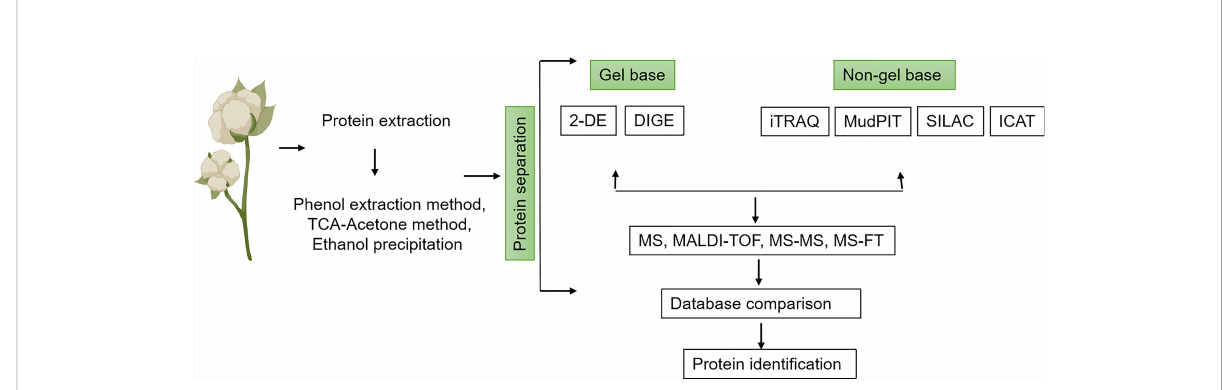
FIGURE 2 Schematic work fl ow of the different methods used in cotton proteomics analysis. Proteins are extracted from tissues of interest using any of the following methods: phenol extraction, TCA-Acetone, or ethanol precipitation. This is followed by protein separation either using a gel base (2- DE or DIGE) or a non-gel base (iTRAQ, MupPIT, SILAC, ICAT) method. Proteins can further be analyzed by MS, MALDI-TOF, MS-MS, or MS-TF. After analysis, data comparison is performed for fi nal protein identi fi